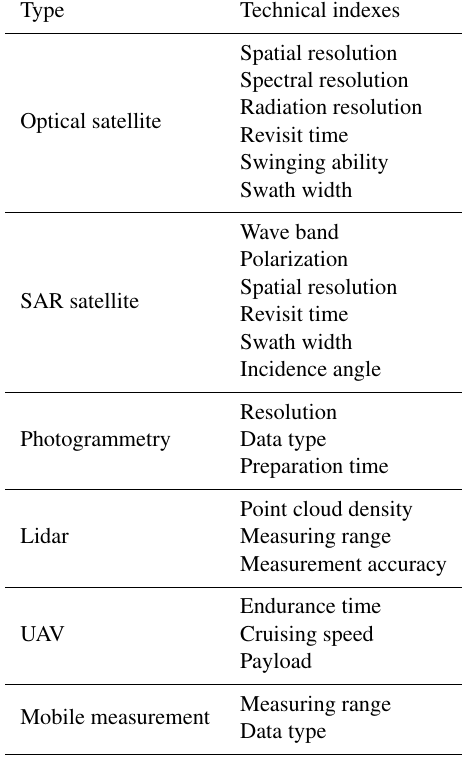
Table 1. Sensor technical indexes.